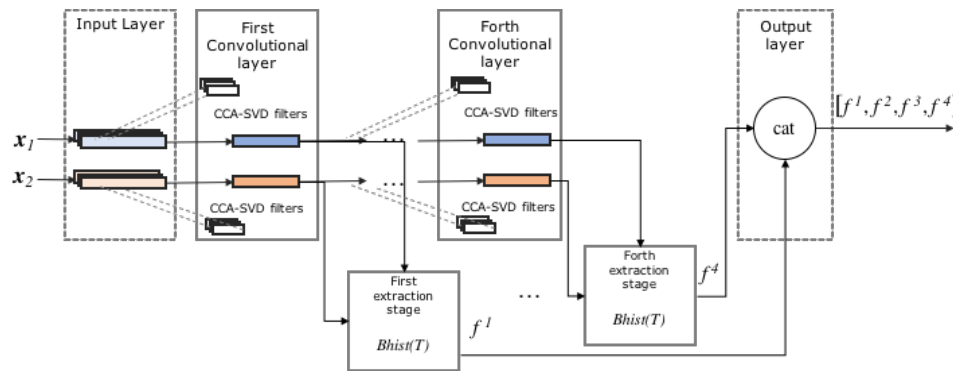
Figure 3. Proposed 1-D